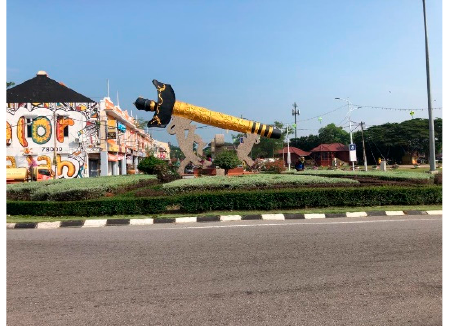
Figure 1. The Keris replica in Alor Gajah town.